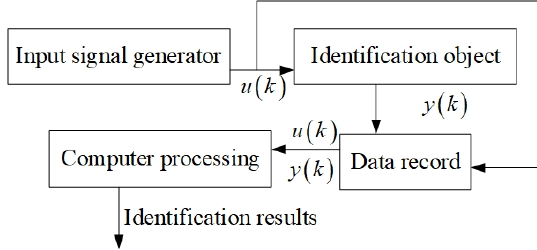
Figure 7. Structure diagram of off-line identification.